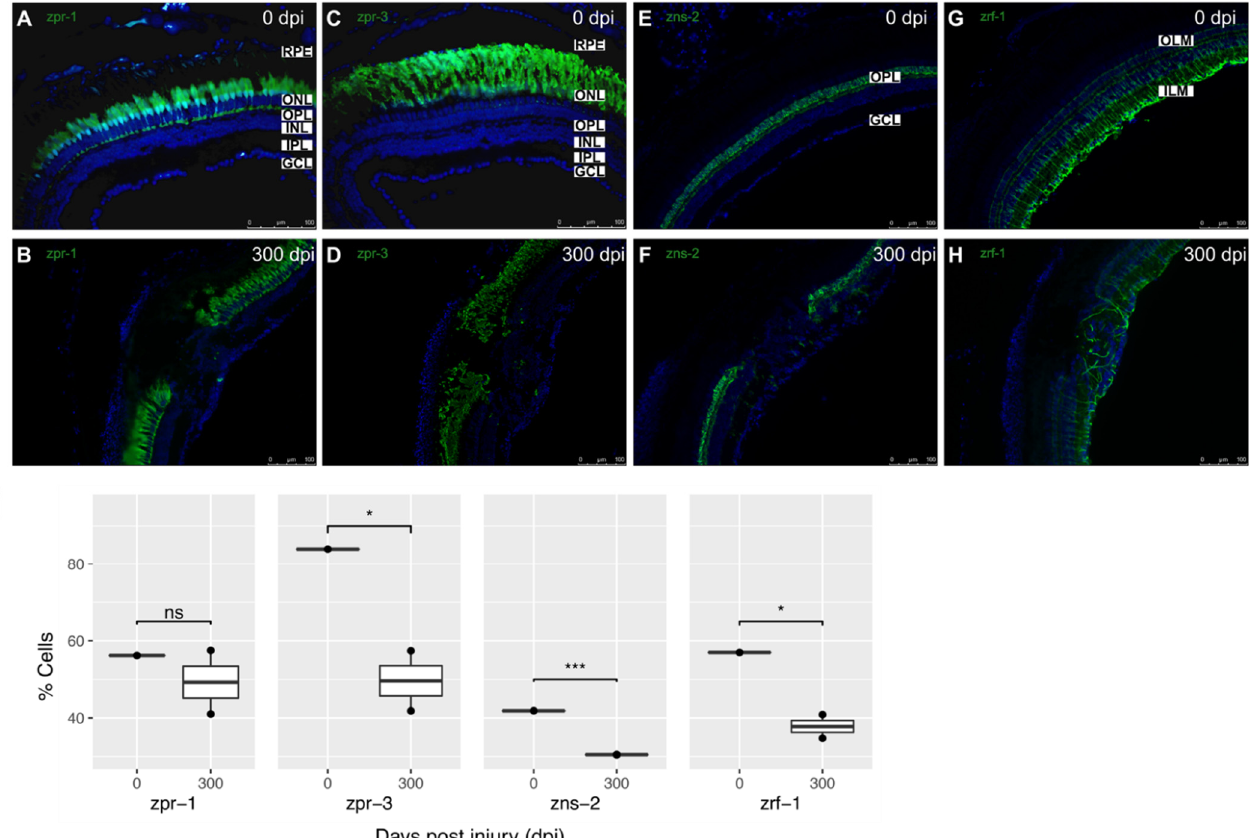
Figure 5. Cellular components of defect at 300 dpi: (i) ( A ) Uninjured retina (0 dpi) showing typical staining of cones with zpr-1 antibody. ( B ) Absence of restoration of cone photoreceptors within the injured retina at 300 dpi. ( C ) Uninjured retina (0 dpi) showing typical staining of rods with zpr-3 antibody. ( D ) Incomplete restoration and disorganization of rod photoreceptors within the lesion at 300 dpi. ( E ) Uninjured retina (0 dpi) showing typical staining of horizontal cells with zns-2 antibody. ( F ) Absence of horizontal cells within the lesion at 300 dpi. ( G ) Uninjured retina (0 dpi) showing typical staining of MG with zrf-1 antibody. ILM and OLM labelled for reference. ( H ) Partial resto- ration of MG within the residual lesion at 300 dpi. All sections were counterstained with DAPI. zpr-